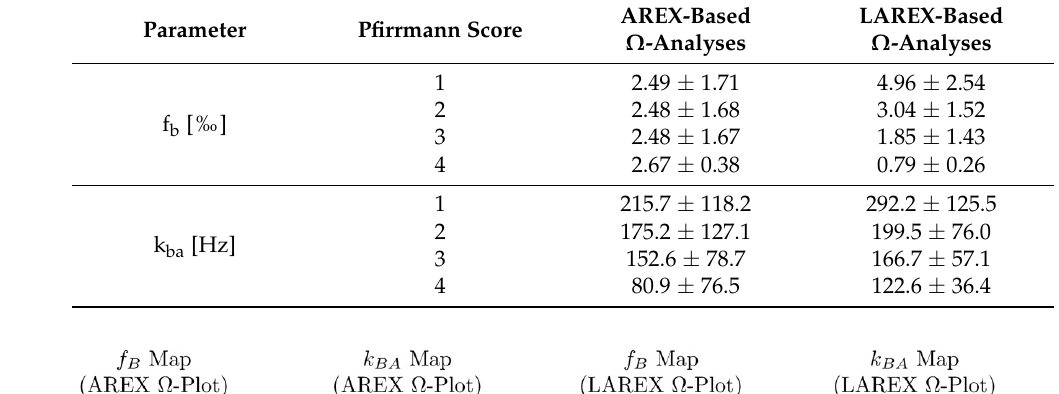
Table 2. Evaluation of the imaging characteristics of fractional concentration (f b ) and exchange rate (k ba ) for the degenerative stage (Pfirrmann score). Each value is expressed as mean and standard deviation.